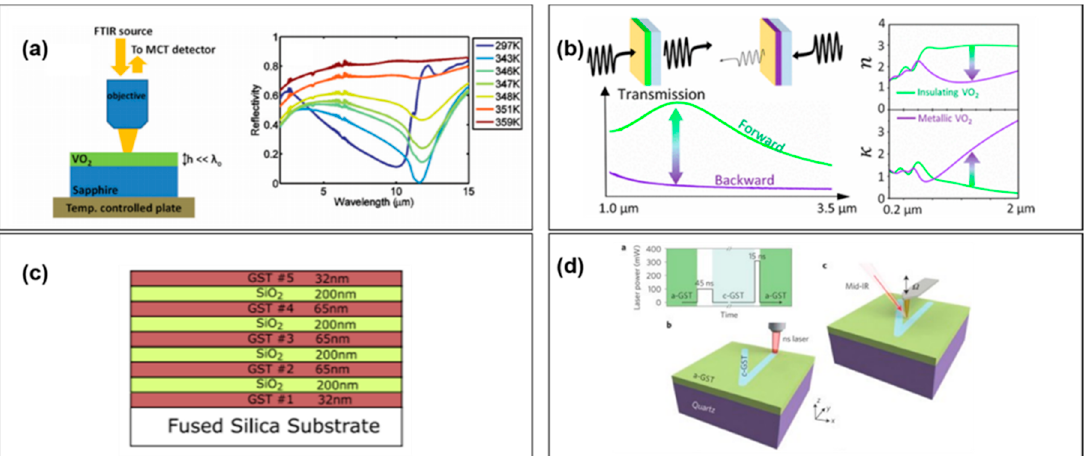
Figure 12. Integration of PCMs within planar multilayer films. ( a ) Reproduced from [58] with permission from AIP. ( b ) Reproduced from [59] with permission from the American Chemical Society. ( c ) Reproduced from [60] with permission from IEEE. ( d ) Reproduced from [61] with permission from Nature Springer.